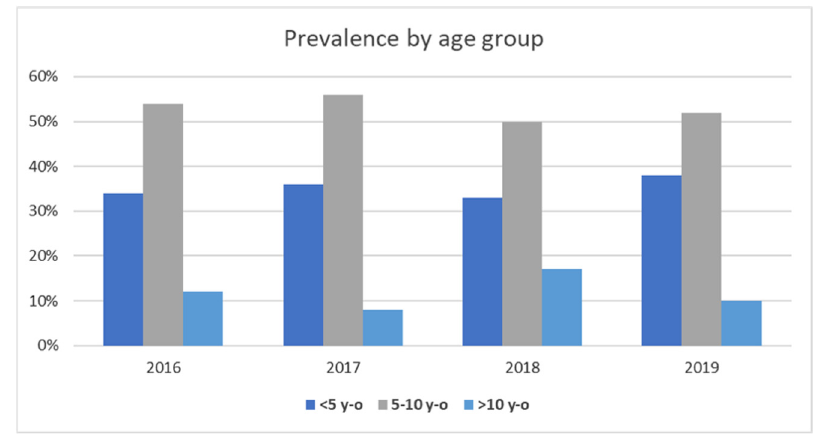
Figure 3 . Prevalence of pet animal skin infections by age group. Figure 3. Prevalence of pet animal skin infections by age group.